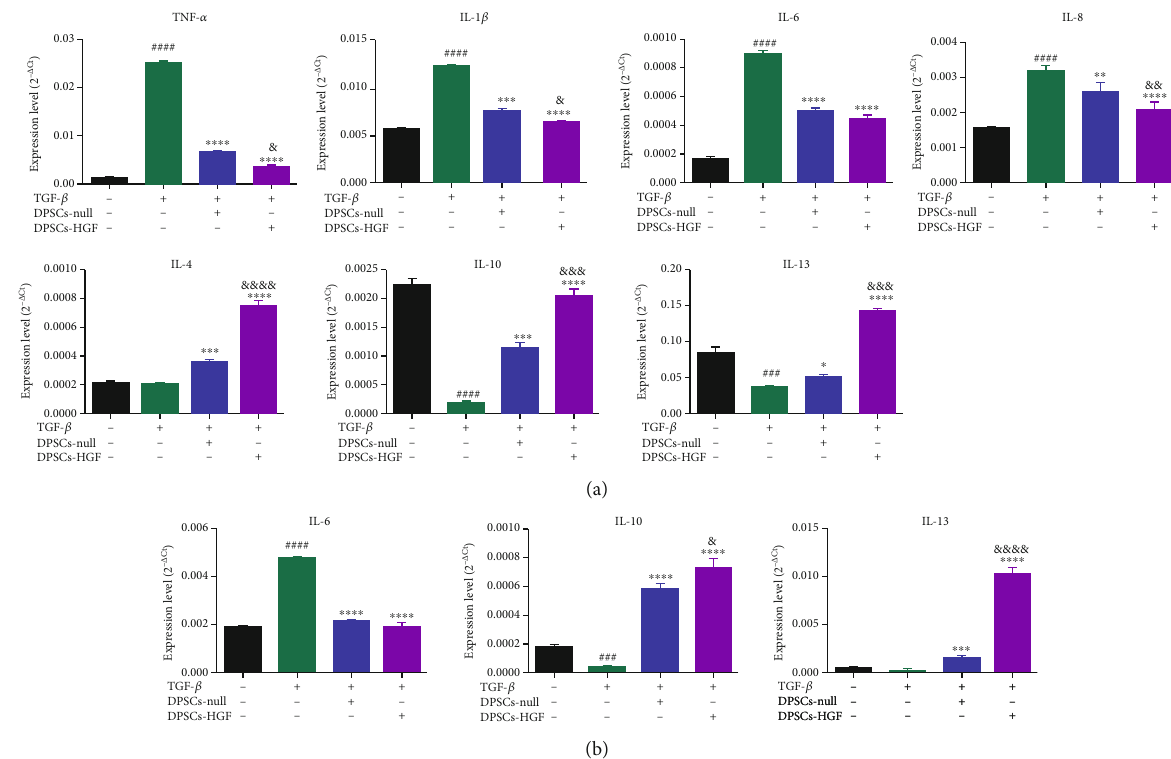
Figure 4: DPSCs-HGF inhibit the in fl ammatory response in BEAS-2B and MRC-5 cells. (a) The expression of in fl ammatory cytokines, including TNF- α , IL-1 β , IL-6, IL-8, IL-4, IL-10, and IL-13, in BEAS-2B cells was measured by qPCR. (b) In fl ammatory-related cytokines, including IL-6, IL-10, and IL-13, in MRC-5 cells were measured by qPCR. Each experiment was performed in triplicate. The data are shown as the means ± SEM . ANOVA followed by Tukey ’ s multiple comparisons test was used to evaluate these data. ### P < 0 : 001 and #### P < 0 : 0001 vs. Con; ∗ P < 0 : 05 , ∗∗ P < 0 : 01 , ∗∗∗ P < 0 : 001 , and ∗∗∗∗ P < 0 : 0001 vs. TGF- β ; & P < 0 : 05 , && P < 0 : 01 , &&& P < 0 : 001 , and